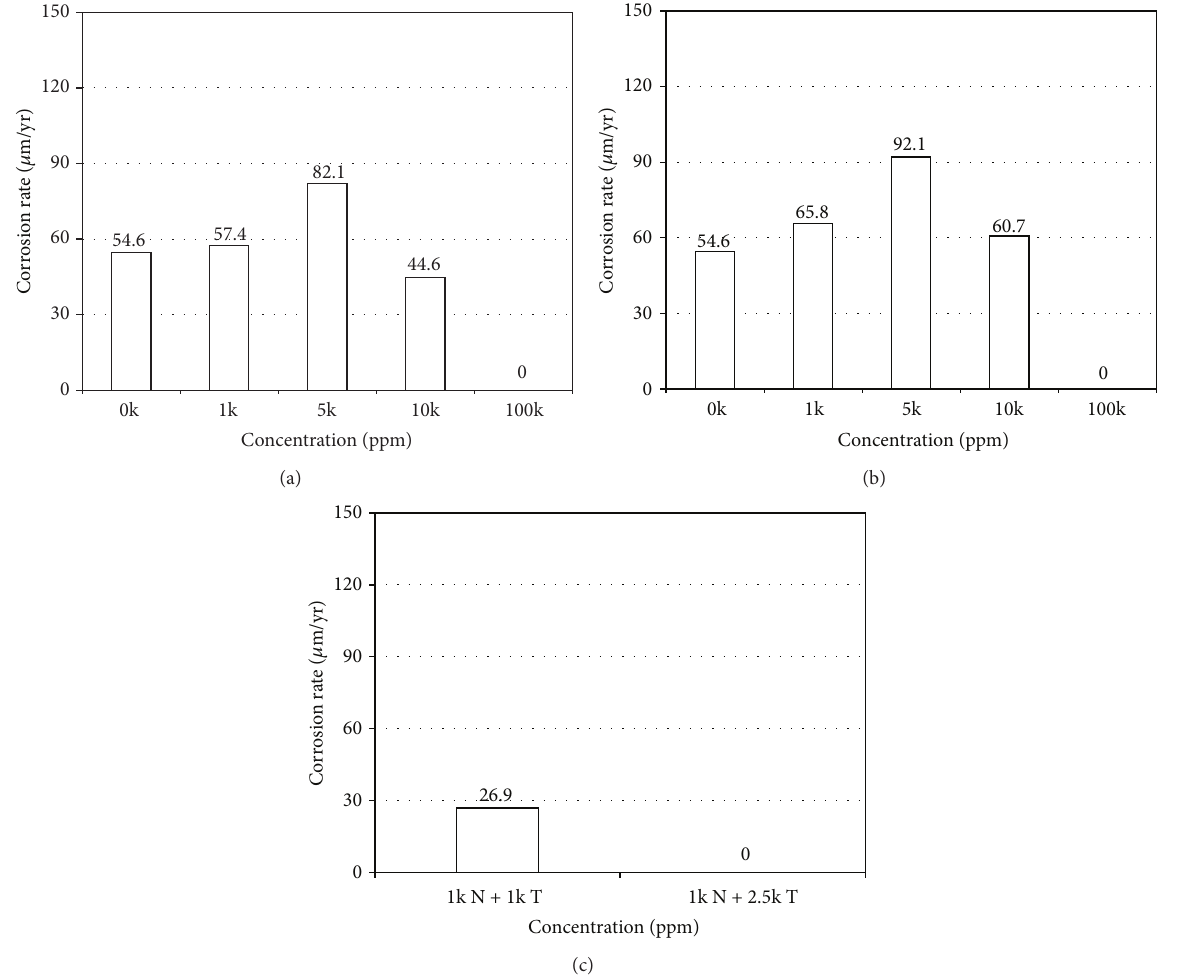
Figure 1: The effect of single addition and coaddition of corrosion inhibitor on the corrosion rates of DCI (25 ∘ C tap water + x ppm corrosion inhibitor). (a) NO 2− , (b) TEA, and (c) NO 2− +